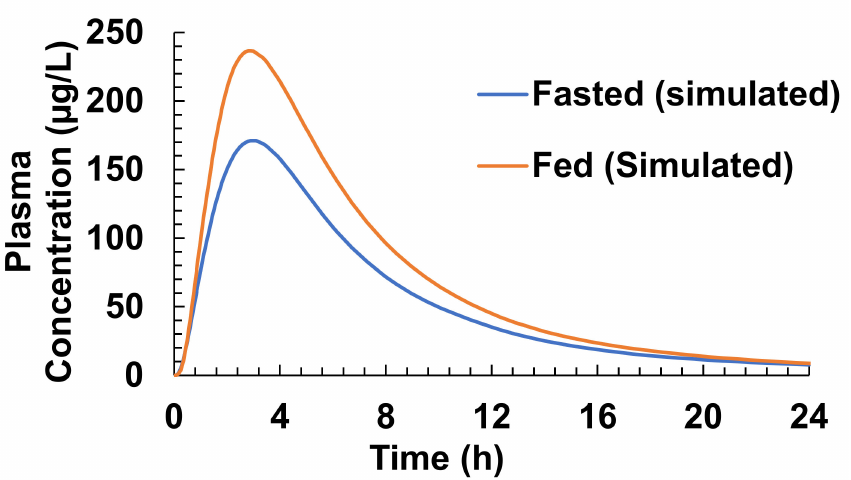
Figure 5. Simulated plasma concentration-time profile of Xarelto (20 mg) in fasted and fed states using GastroPlus TM ACAT